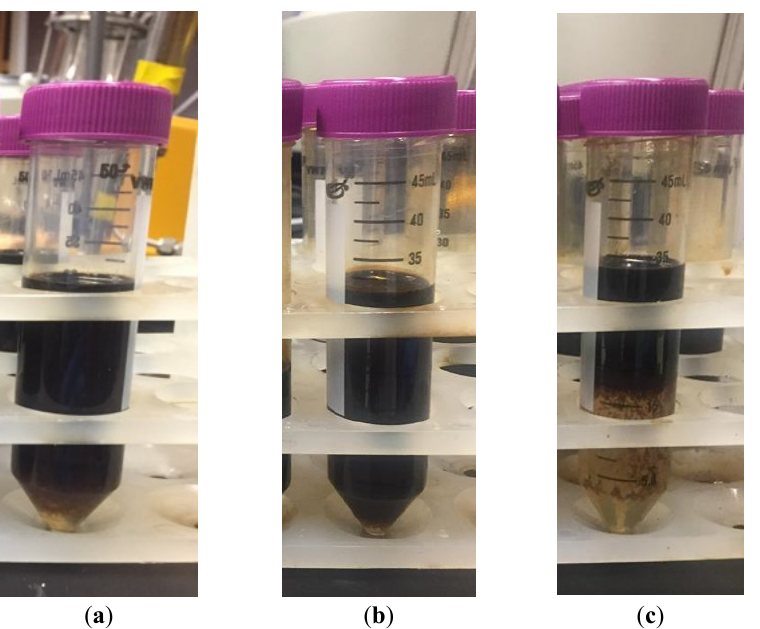
Figure 5. Separation of spent-acid oil emulsion after 5 days whereas ( a ) spent-acid is mixed with crude oil; ( b ) spent-acid is mixed with oil and surfactant; and ( c ) spent-acid and de-emulsifier is mixed with oil and surfactant.